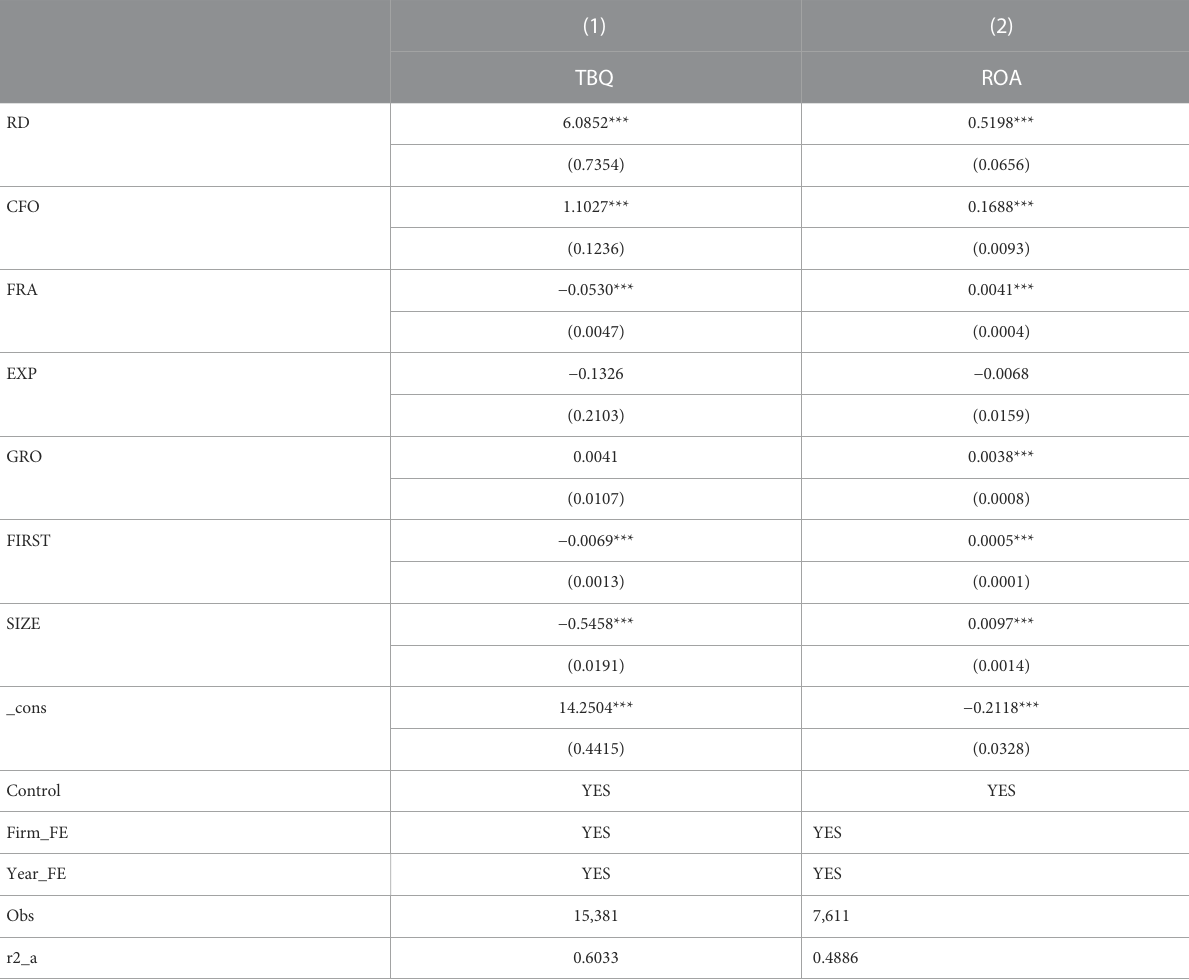
TABLE 4 Robustness test